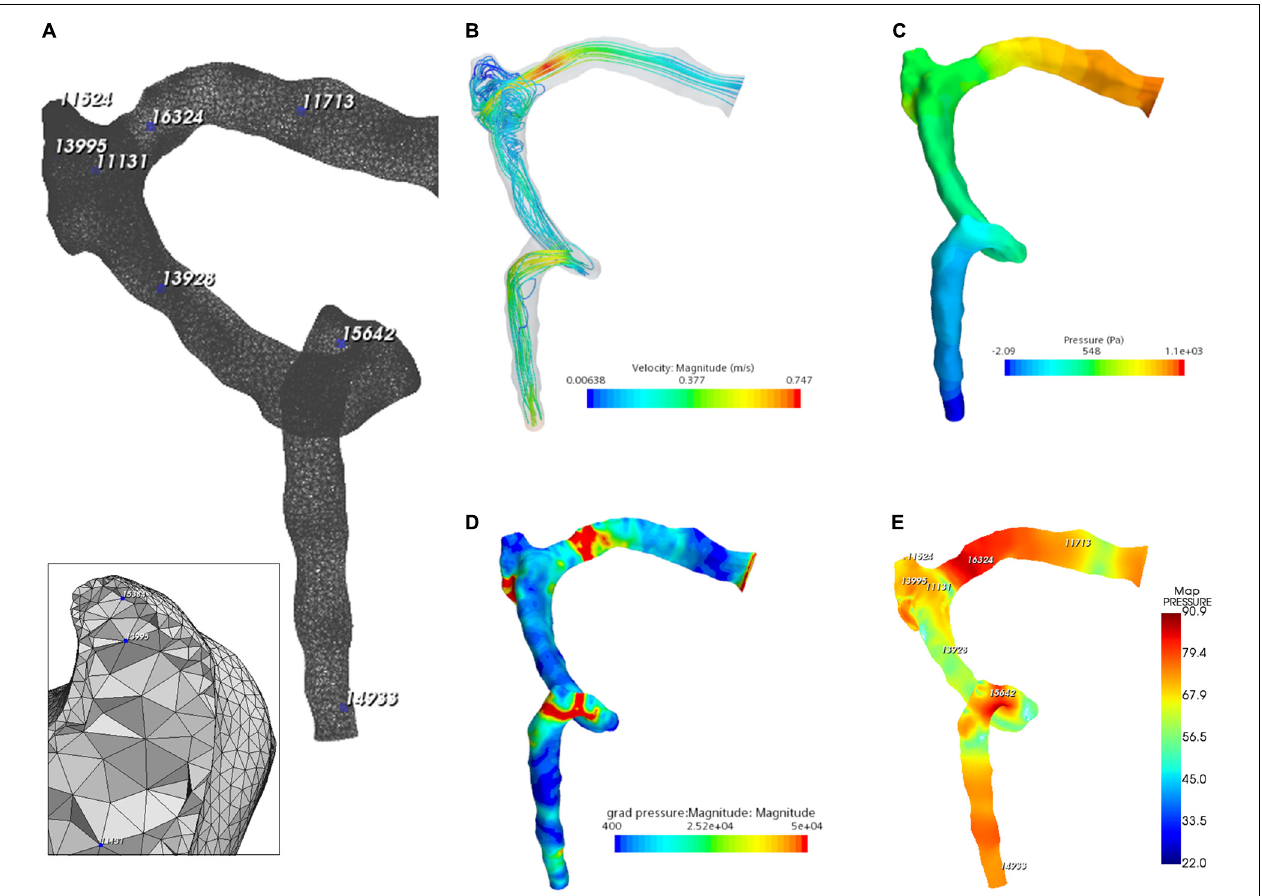
FIGURE 6 | Hydroacoustic characteristics of the ipsilateral transverse–sigmoid sinus. (A) A 3D finite element model of ipsilateral transverse–sigmoid sinus of case 3. Eight nodes were chosen for hydroacoustic evaluation. (B) Velocity streamline of the ipsilateral transverse–sigmoid sinus. (C) Wall pressure distribution of the ipsilateral transverse–sigmoid sinus. (D) Pressure gradient distribution of the ipsilateral transverse–sigmoid sinus (unit: Pa/m). (E) Acoustic distribution of the ipsilateral transverse–sigmoid sinus (unit: